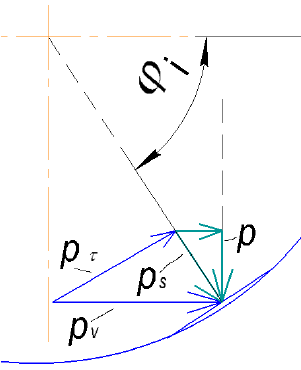
Figure 4. Determining indenter pressing down stress p.